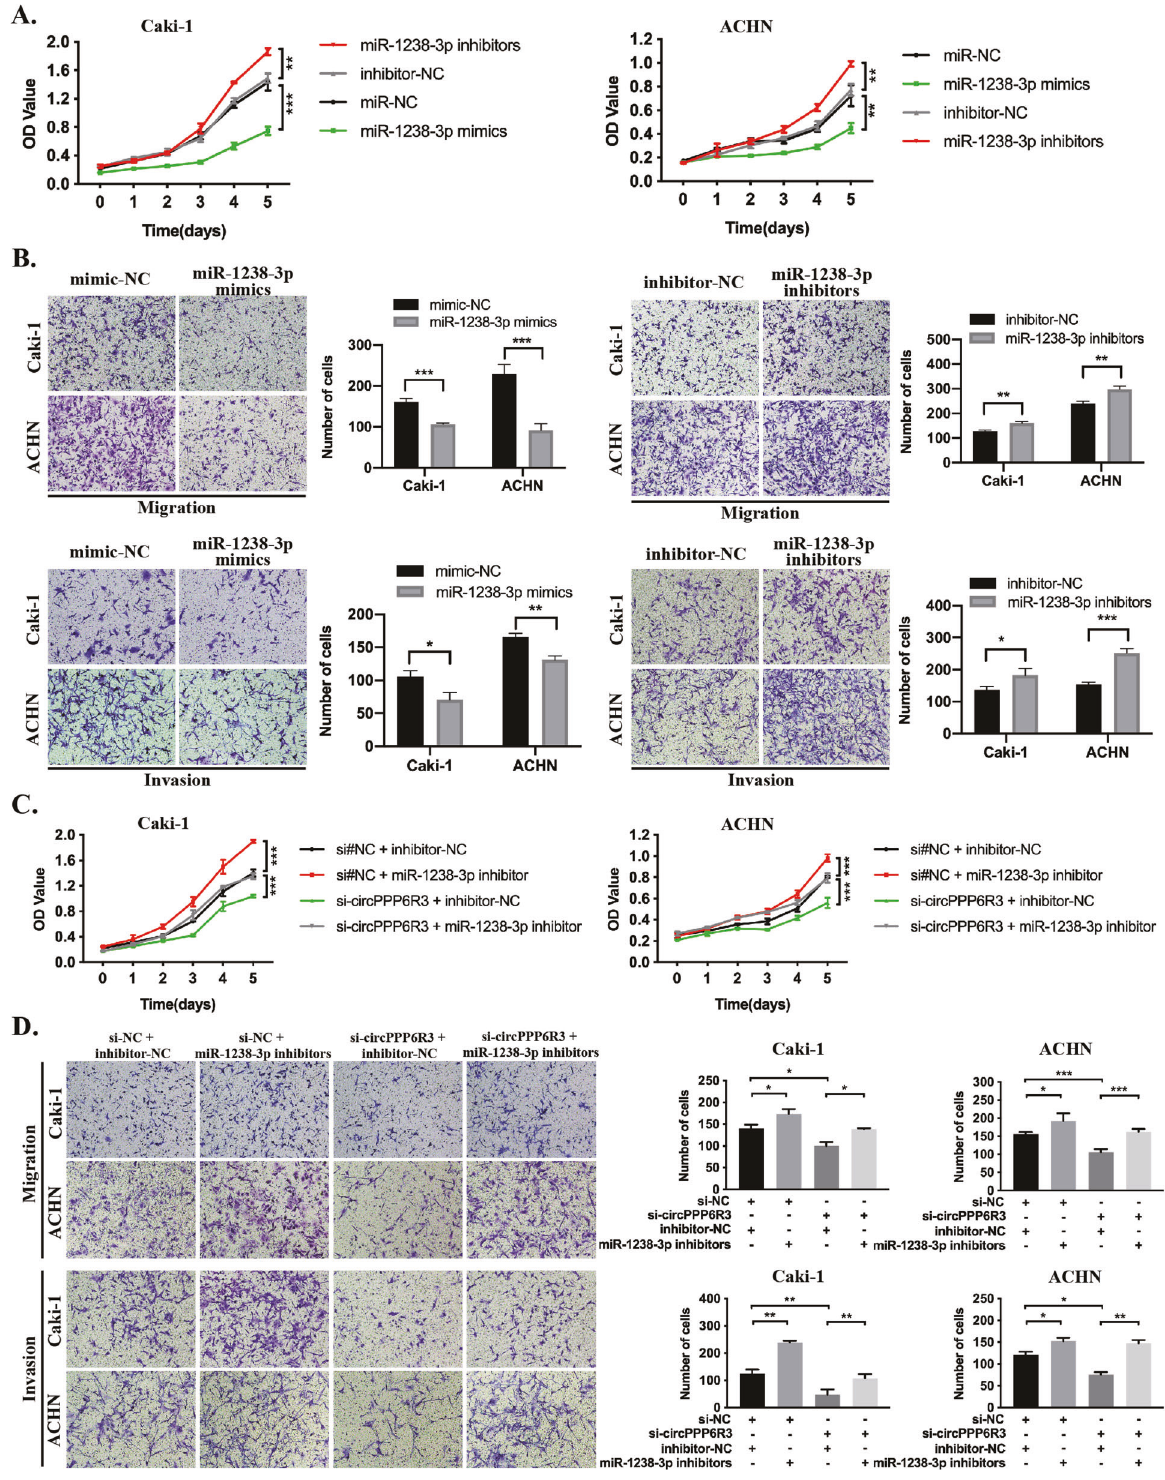
Fig. 5 circPPP6R3 functions through interacting with miR-1238-3p in ccRCC cells. A The MTS assay was conducted to evaluate the ability of proliferation of miR-1238-3p in ccRCC cells. B The migration and invasion assay were employed to verify the role of miR-1238-3p on metastatic capacity in ccRCC cells. C The MTS assay was adopted to investigate the ability of proliferation of miR-1238-3p inhibitors in circPPP6R3- knockdown ccRCC cells. D The migration and invasion assay was conducted to validate the metastatic function of miR-1238-3p inhibitors in circPPP6R3-knockdown ccRCC cells.